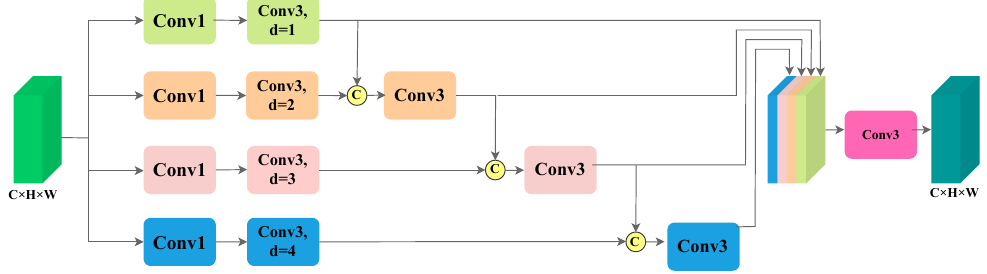
Figure 4. Architecture of the PFA